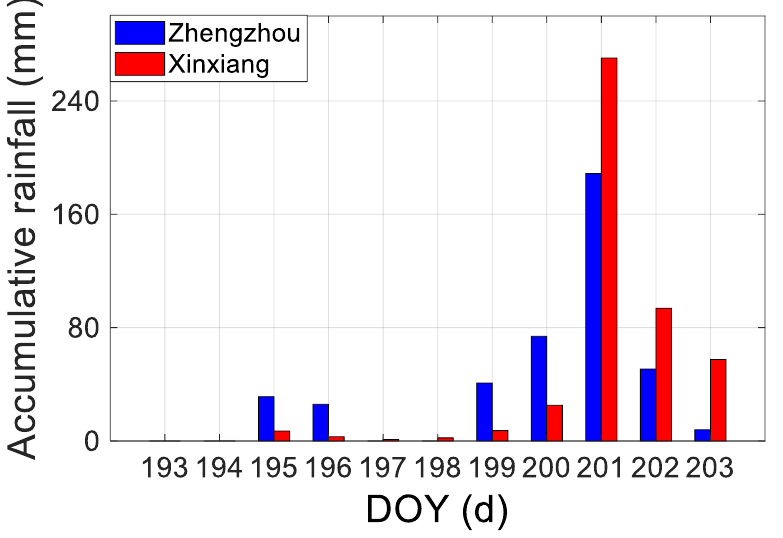
Figure 2. Accumulative rainfall from DOY:193, 2021 to DOY:203, 2021 in Zhengzhou and Xinxiang, China. The blue and red bars denote Zhengzhou and Xinxiang, respectively.